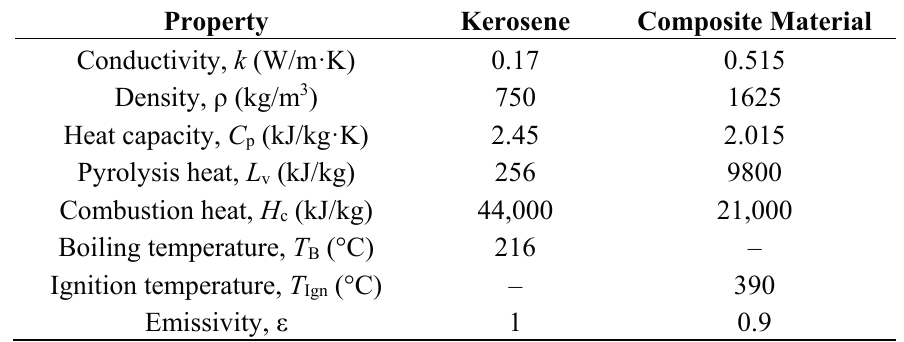
Table 1. Material property for the liquid fuel (kerosene) and the composite